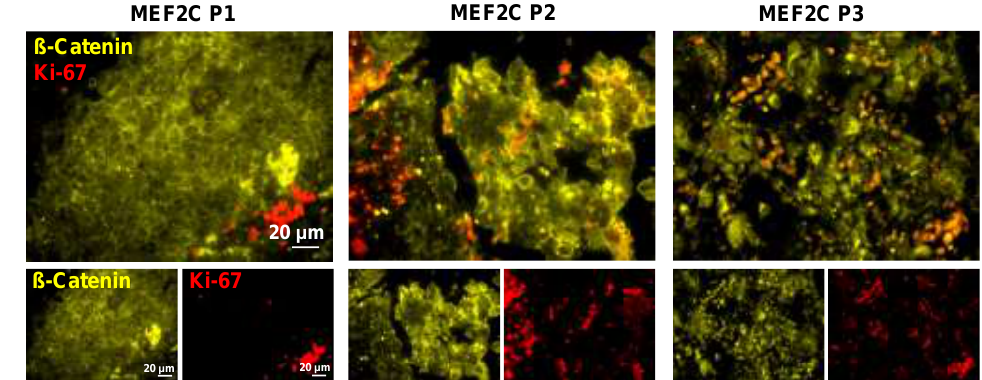
Figure 4. Ki-67 and ß-catenin (CTNNB1) expression in resected human breast cancer brain metastases. Double-labeling immunofluorescence analysis was performed in tissue sections from breast cancer brain metastases representative of each myocyte enhancer factor 2C (MEF2C) expression phenotype (P1, P2, and P3). Analysis of the proliferation marker Ki-67 (red) in metastases labeled with β-catenin (yellow) revealed the presence of Ki-67 positive cells at the periphery of metastasis in which β-catenin was mainly expressed at the cell membrane (corresponding to MEF2C P1), as well as an increasing number of Ki-67 positive cells and their presence inside metastases as β-catenin dislocated to the cytosol and nucleus (corresponding to MEF2C P2 and P3). Ten fields of one representative section of each MEF2C phenotype were analyzed.